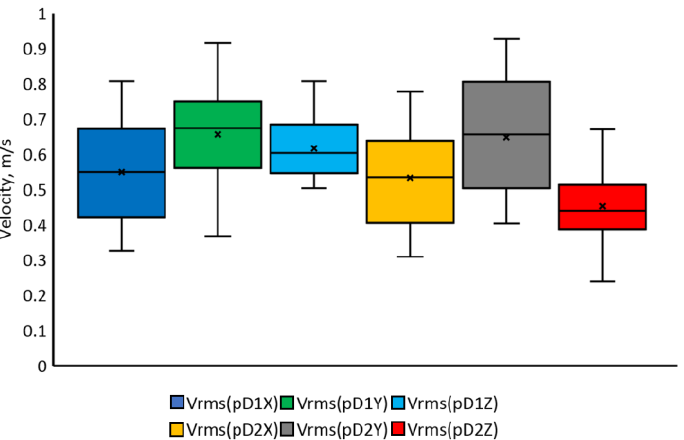
Figure 11. Summary of the maximal velocity values obtained in the study of reaching movements in the deceleration phase.